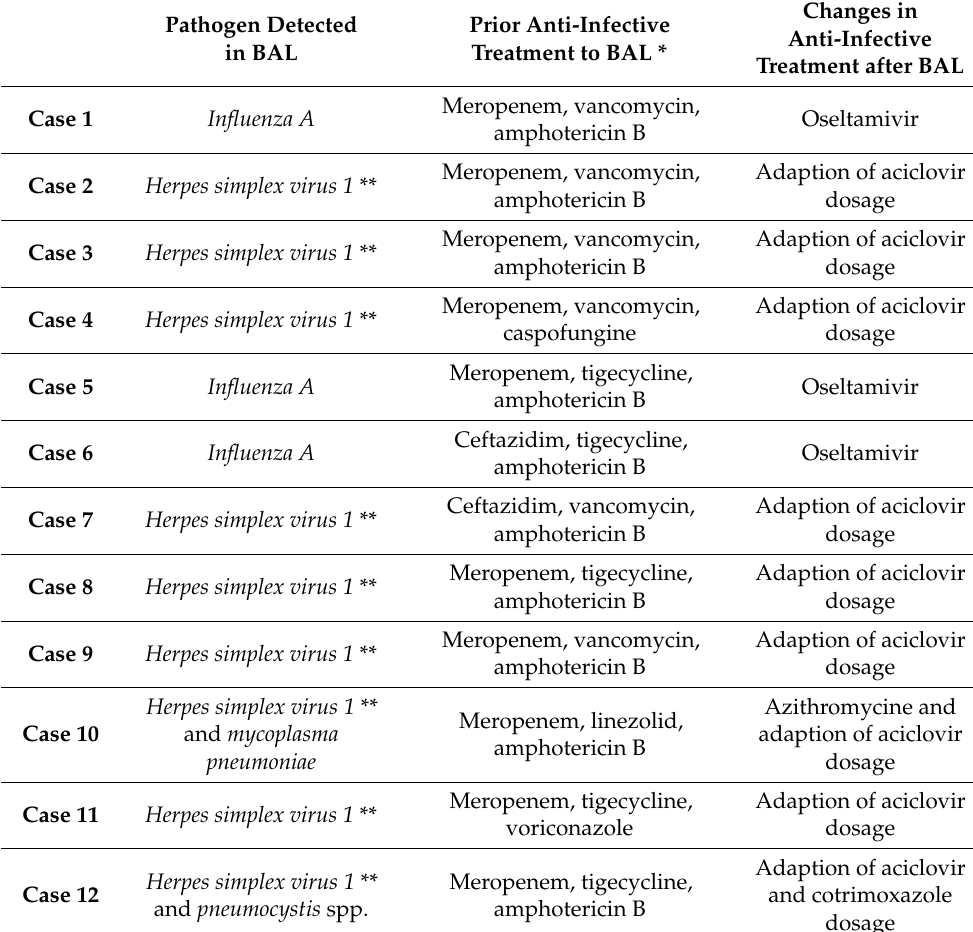
Table 2. BAL-driven changes of anti-infective treatment